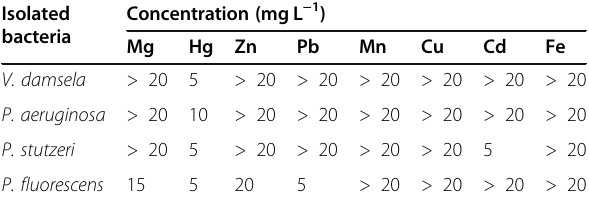
Table 4 MIC values of heavy metals in the bacteria Isolated bacteria